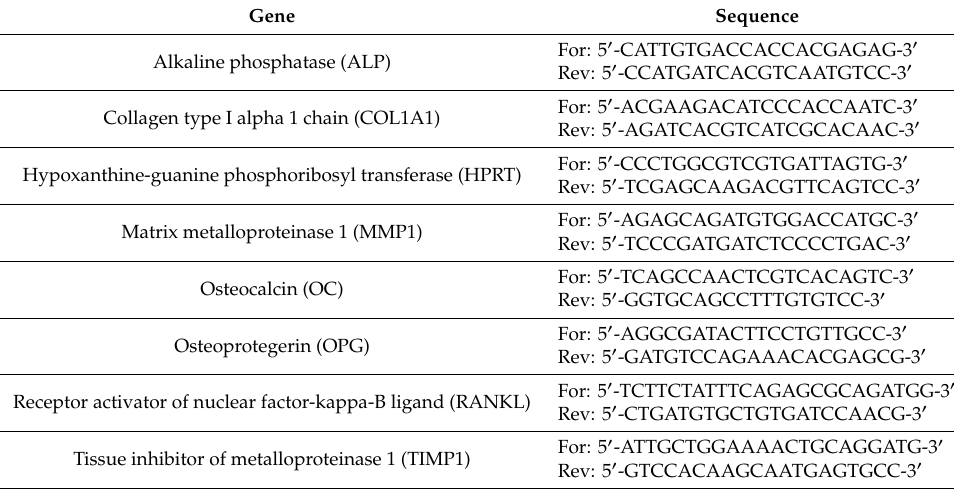
Table 2. Genes and primer sequences (purchased from Sigma-Aldrich (Merck), Darmstadt, Germany) analyzed using quantitative Real-Time Polymerase Chain